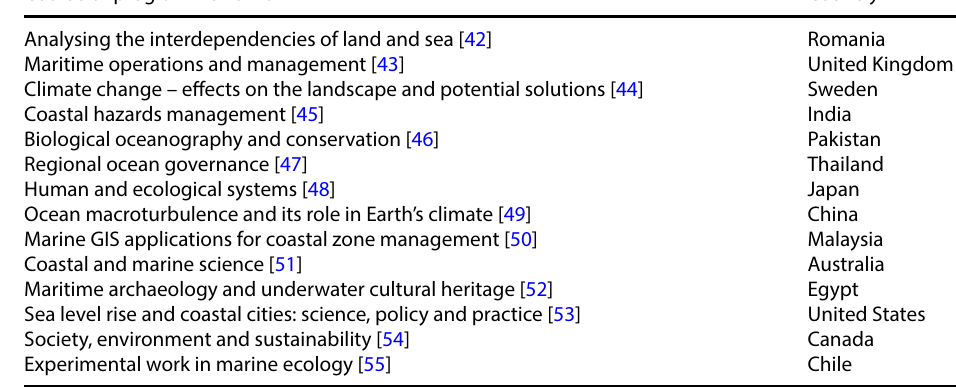
Table 1 A selected sample of higher education courses and programmes currently (2022) or recently taught, with connections to sustainability in the Land–Sea